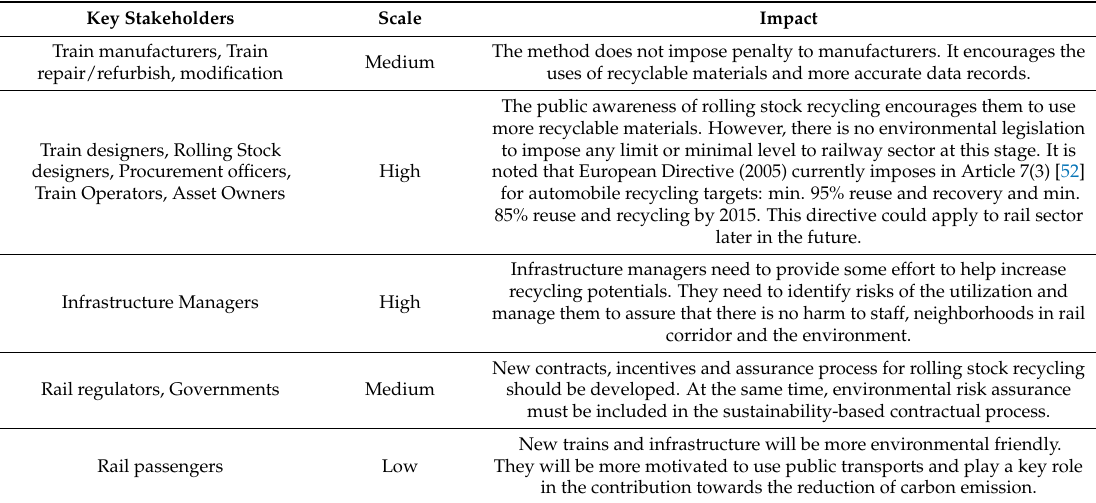
Table 4. Stakeholders and impact of recycling and reusing aging